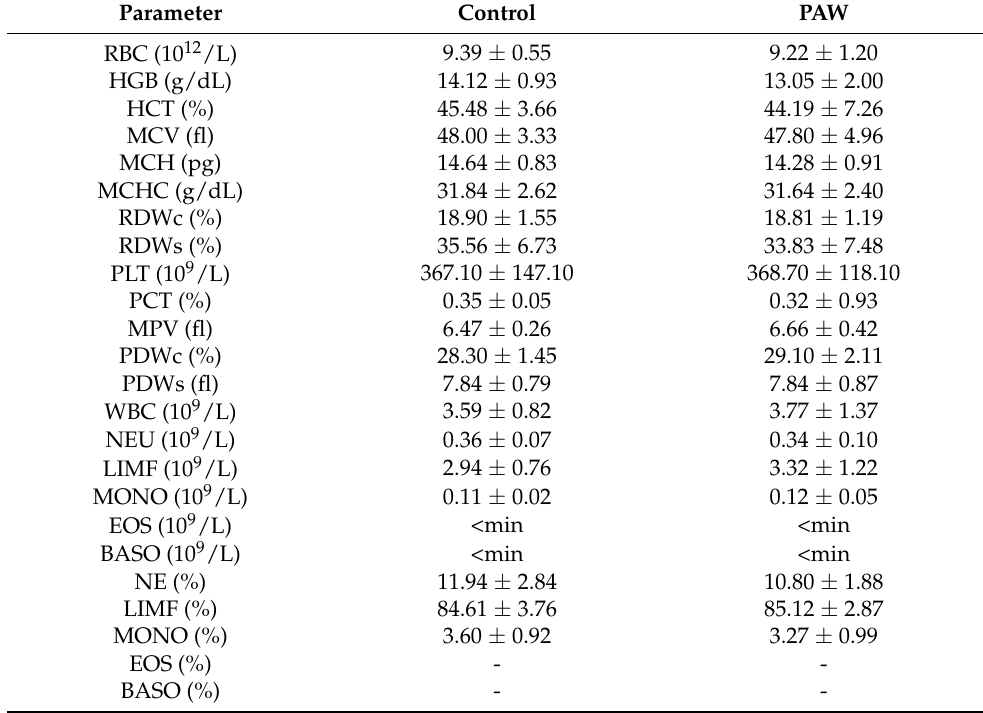
Table 3. Hematological parameters.